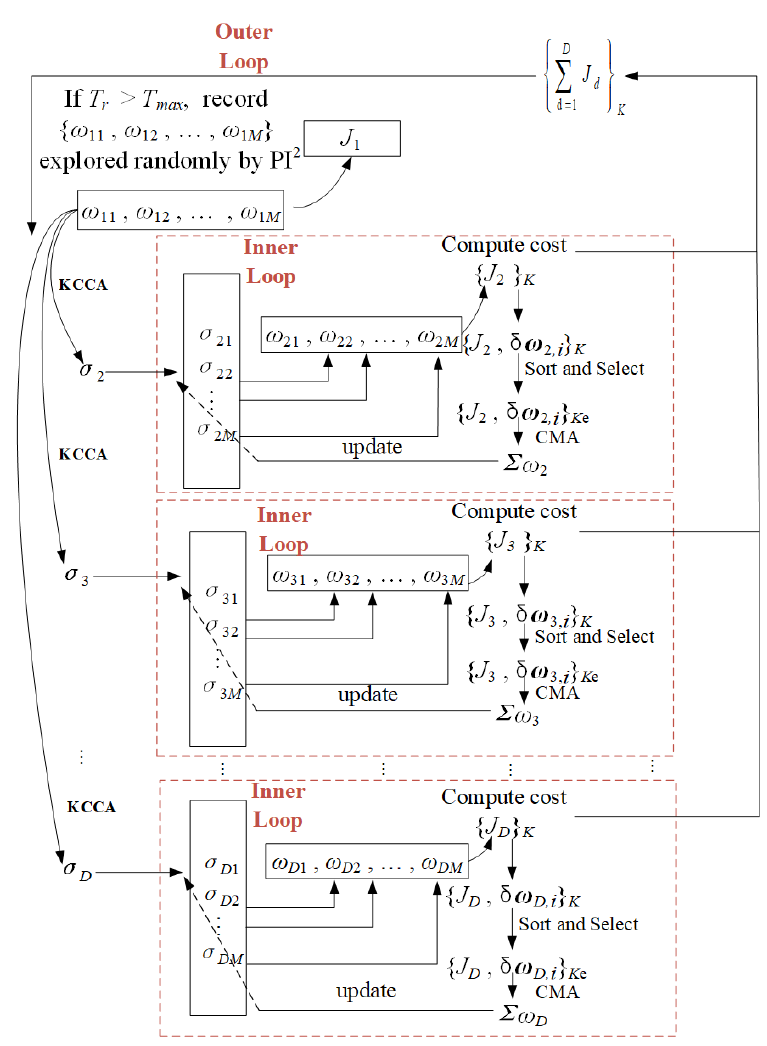
Figure 1. A typical system’s architecture for PI 2